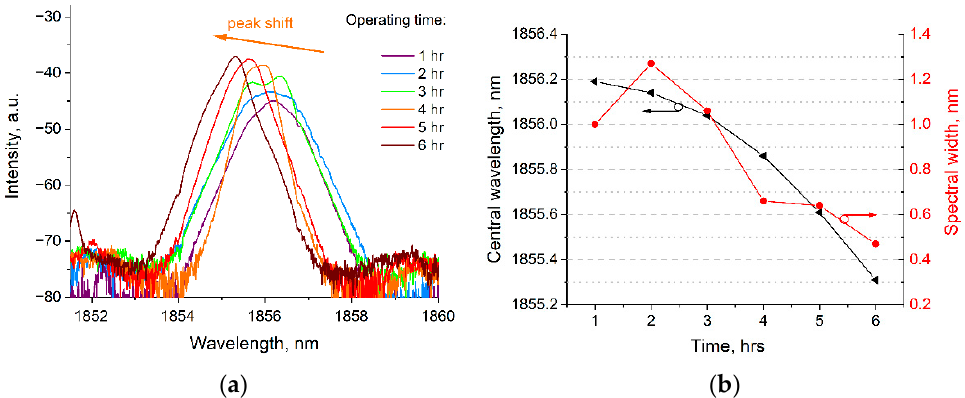
Figure 4. Variation in output spectra vs. time ( a ). Central wavelength of the lasing spectrum (triangles) and corresponding spectral width (circles) variation with time ( b ).